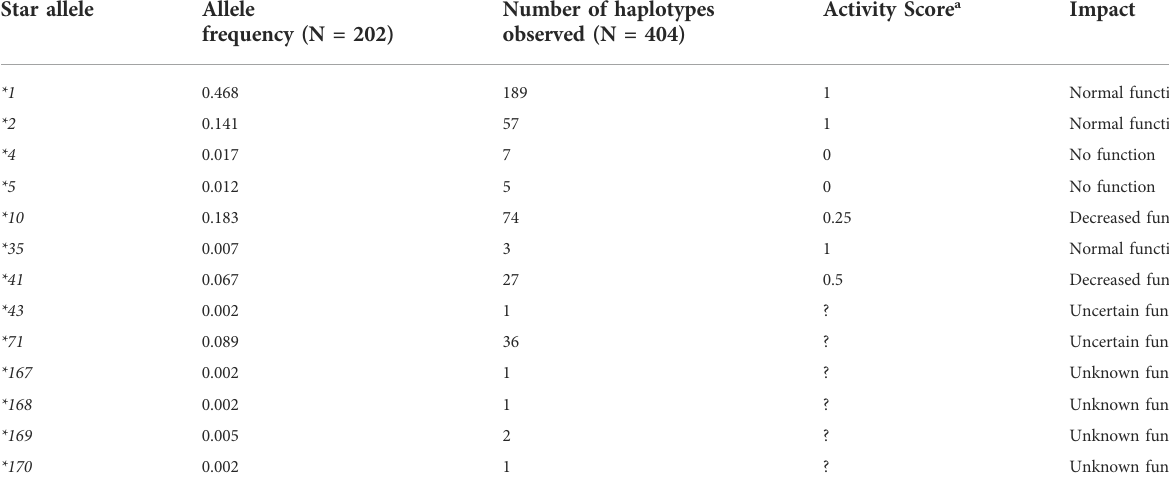
TABLE 2 Star allele frequencies and associated information.